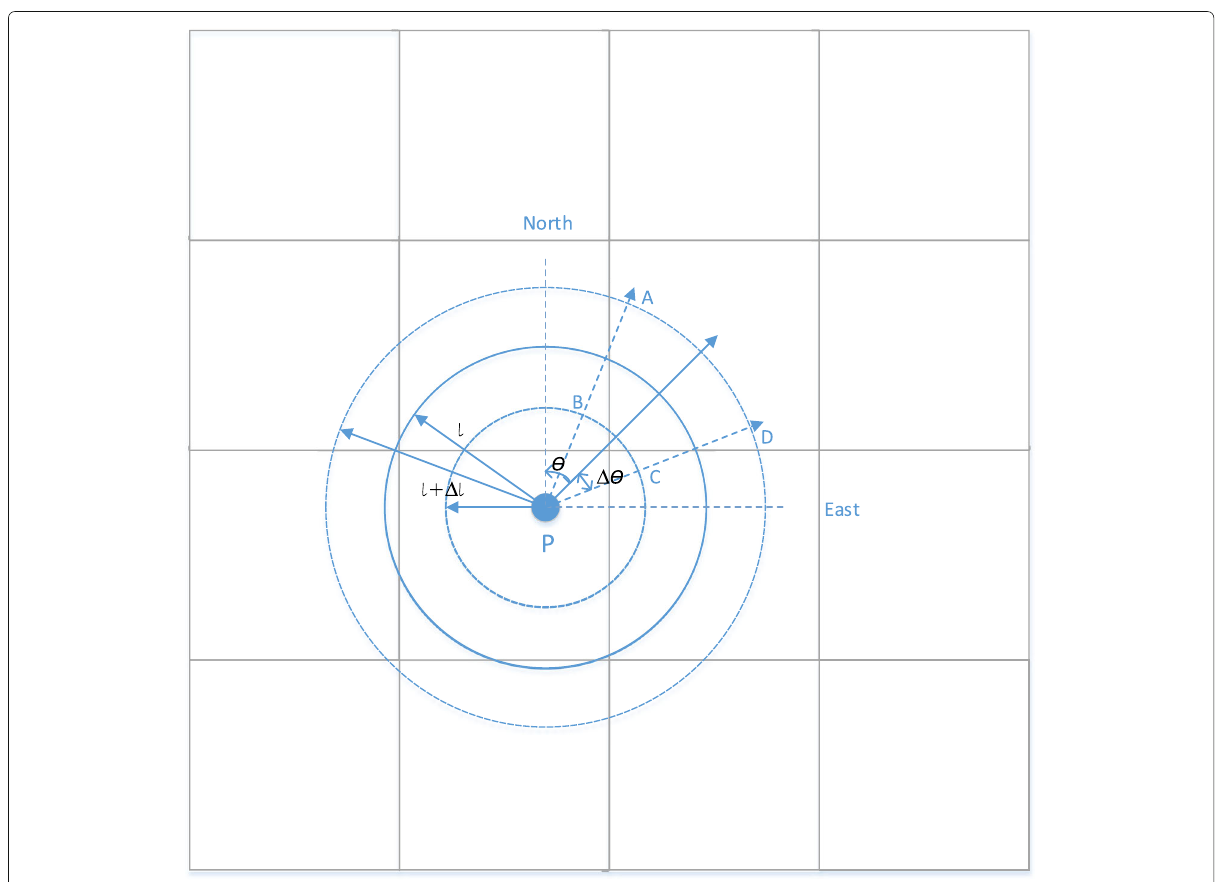
Fig. 4 Sensor-assisted matching in local map tile cache